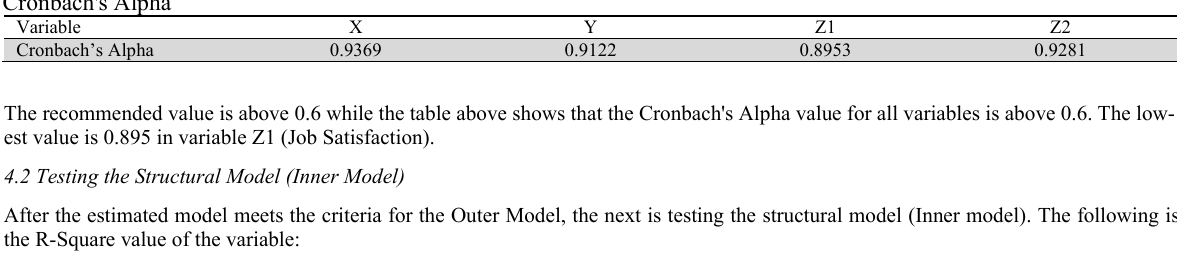
Table 6 The results of R-Square